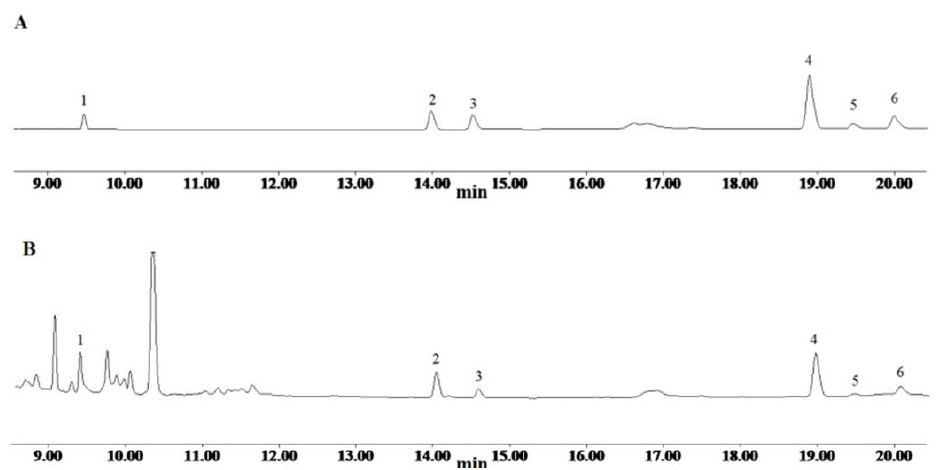
Figure 1. The chromatogram of reference substances ( A ) and Paris polyphylla var. yunnanensis ( B ) . 1. Pseudoprotodioscin; 2. Polyphyllin VII; 3. Polyphyllin H; 4. Polyphyllin II; 5. Dioscin; 6. Polyphyllin